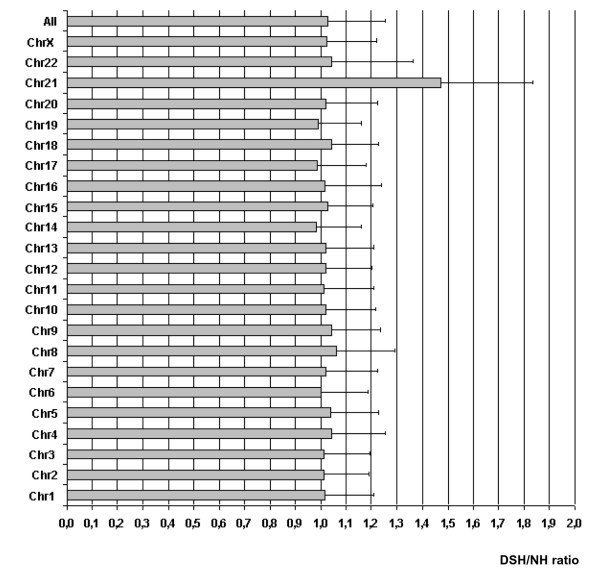
DSH/NH ratio of gene expression calculated for each chromosome and for all the chromosomes. Cumulative gene expression (raw data) was calculated for each chromosome and for all chromosomes and expressed as ratio between DSH and NH samples. Differences among chromosomes were evaluated using the ANOVA one-way test with Bonferroni post-hoc multiple comparison test. Only the difference between Hsa21 and any other chromosome is significant (p < 0.0001). Other comparisons among chromosomes are not statistically significant. The mean DSH/NHs ratio is ~1 for all the chromosomes and 1.48 ± 0.35 for Hsa21. DSH = Heart samples from fetuses with Hsa21 trisomy (includes the samples: CDH1, CDH2, CDH4, CDH5, CDH6 from fetuses with heart defects, and the samples: DH1, DH3, DH4, DH5, DH6 from fetuses without heart defects). NH = Heart samples from control non trisomic fetuses (includes the samples: H1, H2, H3, H4, H5).